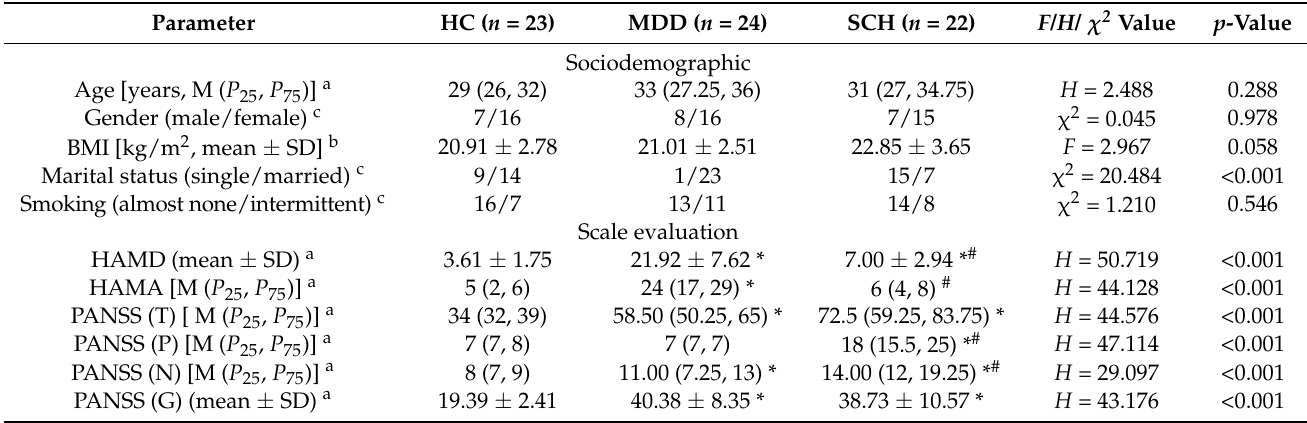
Table 1. The comparison of clinical characteristics data and symptom scale assessment among the three groups.